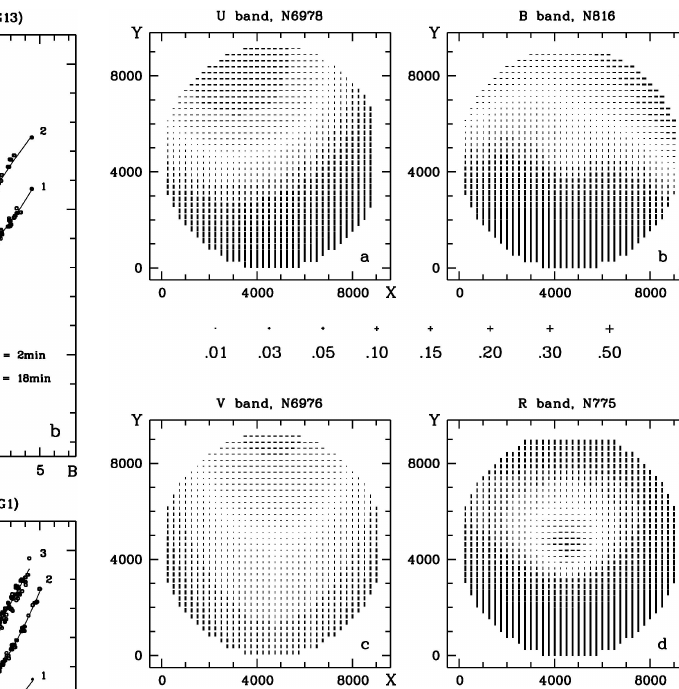
Figure 9. Photometric field error for plates exposed in U, B, V, R